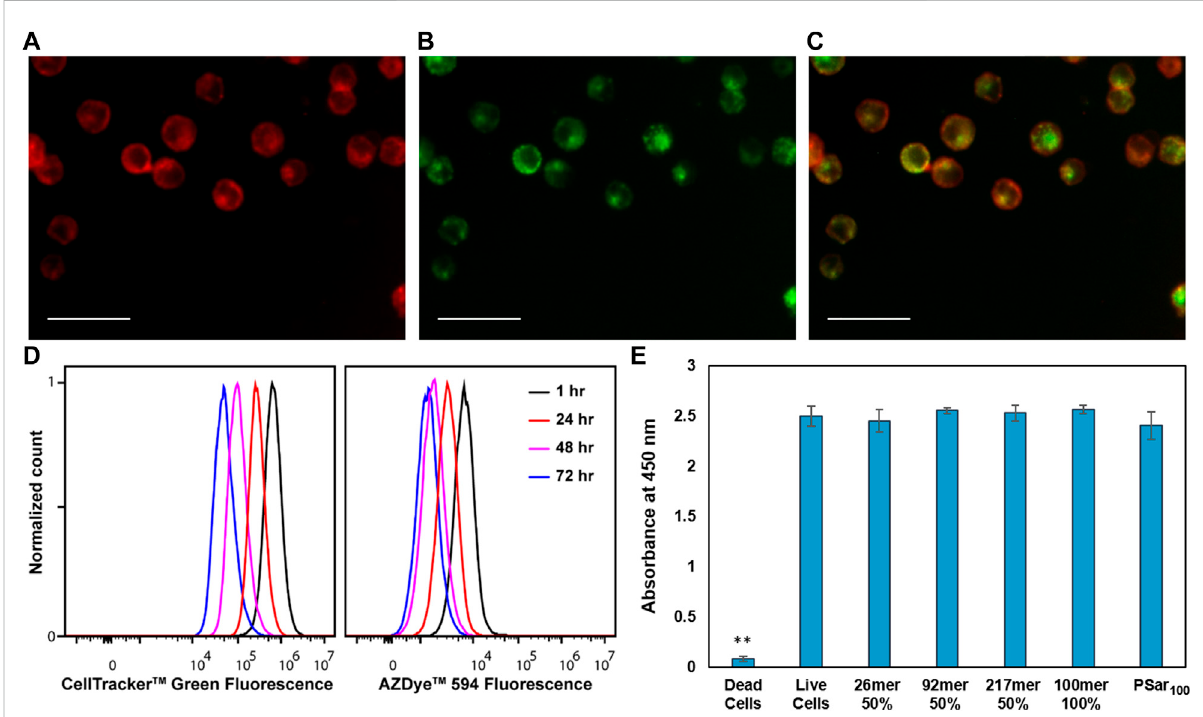
FIGURE 4 CholA-synMUCs are non-cytotoxic, are internalized into recycling endosomes, and are transferred to daughter cells. Fluorescence images demonstrating co-localization of (A) AZ594-labeled 50% glycosylated 92mer synMUC with (B) CF488A-transferrin in HEK cells. (C) is an overlay of the images in (A,B) . Scale bars for (A – C) are 50 µm. (D) Flow cytometry histogram data collected over period of 4 days for Raji cells coated with 50% glycosylated 92mer synMUC and treated with Cell Tracker green. Cells were analyzed at various time points. Unimodal populations were observed suggesting equal distribution of polymer among daughter cells. (E) CCK8 Cytotoxicity assay for HEK cells glycocalyx engineered with various synMUCs. Data was collected 4 days post-engineering. No statistical effect on viability was observed as compared to the live cell control. ** Indicates statistical signi fi